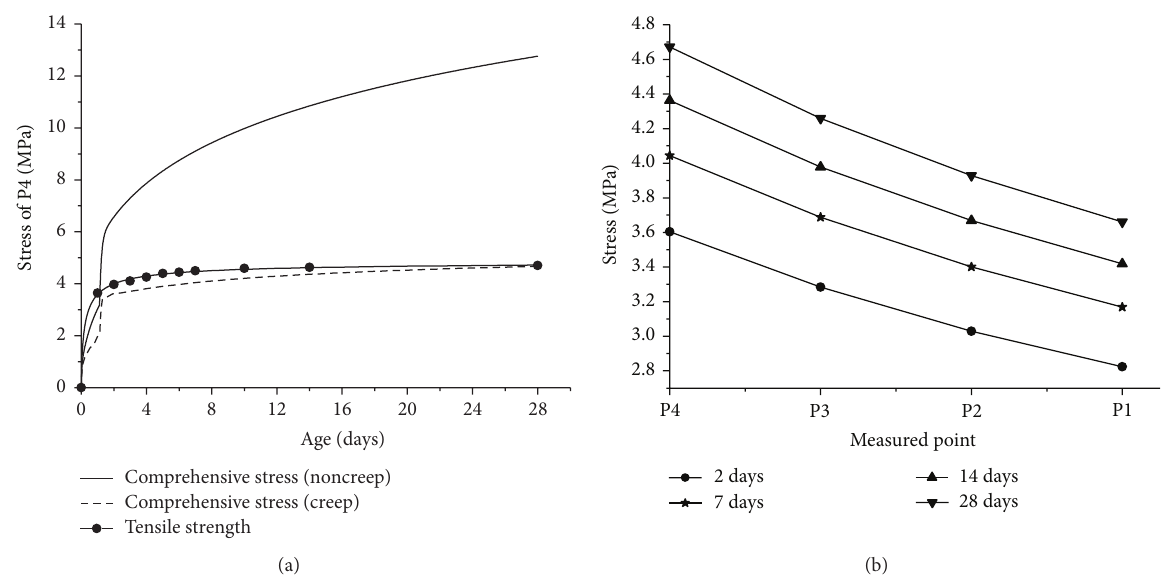
Figure 11: The final comprehensive residual stresses of the restrained mortar ring. (a) Maximum comprehensive residual stresses, at Point 4 of the mortar ring; (b) comprehensive residual stress distribution with age.